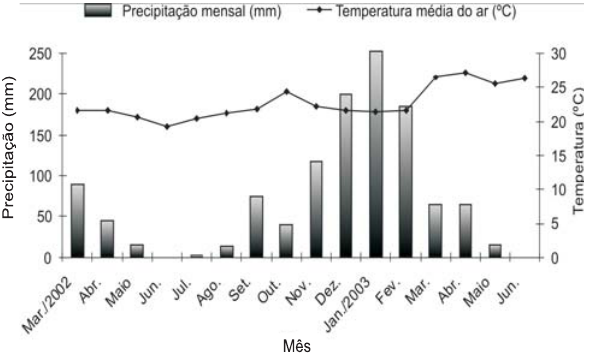
Figura 1. Distribuição das chuvas e temperatura média do ar, no ano agrícola 2002/2003, Planaltina, DF (estação meteorológica da